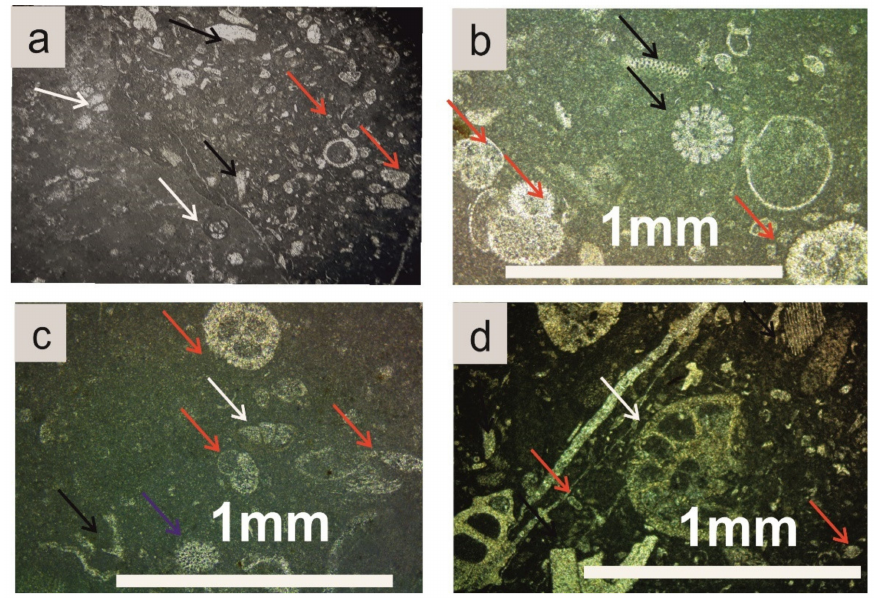
Figure 16. Microfacies type F2: Polymict clast supported microbreccia of Eocene age. ( a ) planktic foraminifera (red arrow), bioclasts’ debris (black arrow), benthic foraminifera (white arrow, sample M16, ( b ) planktic foraminifera (red arrow), bioclasts’ debris (black arrow), sample M15, ( c ) planktic foraminifera (red arrow), bioclasts’ debris (black arrow), benthic foraminifera (white arrow), radiolaria (purple arrow), sample M16, ( d ) planktic foraminifera (red arrow), bioclasts’ debris (black arrow), benthic foraminifera (white arrow), sample